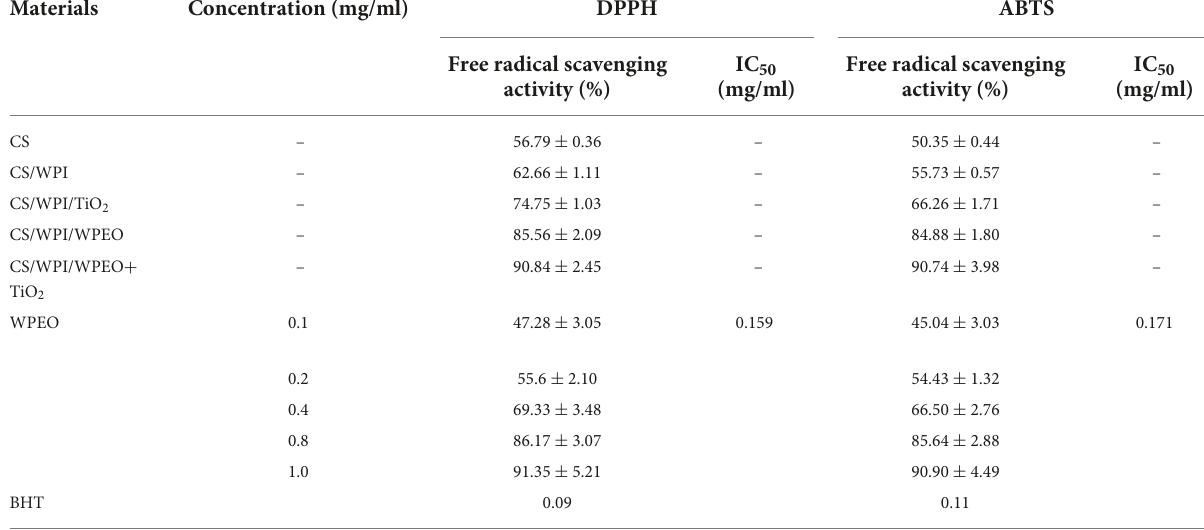
TABLE 3 DPPH and ABTS free radical scavenging activity of WPEO and films